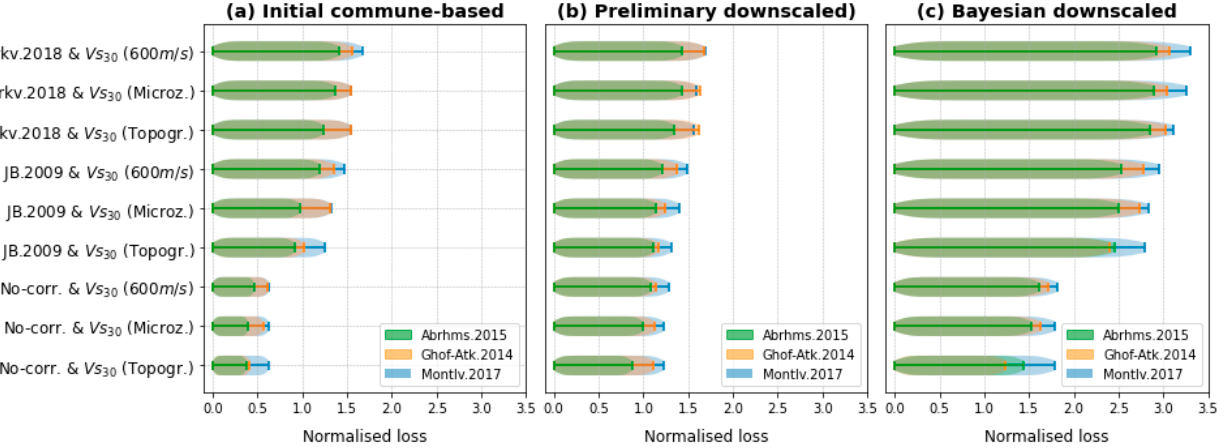
Figure 15. Normalised loss for the earthquake scenario in Valparaíso for the three exposure models (in each subplot) and 27 ground motion assemblages using the set of uncorrelated ground motions with Vs 30 (Topogr.) with the Abrahams 2015 GMPE as a benchmark.